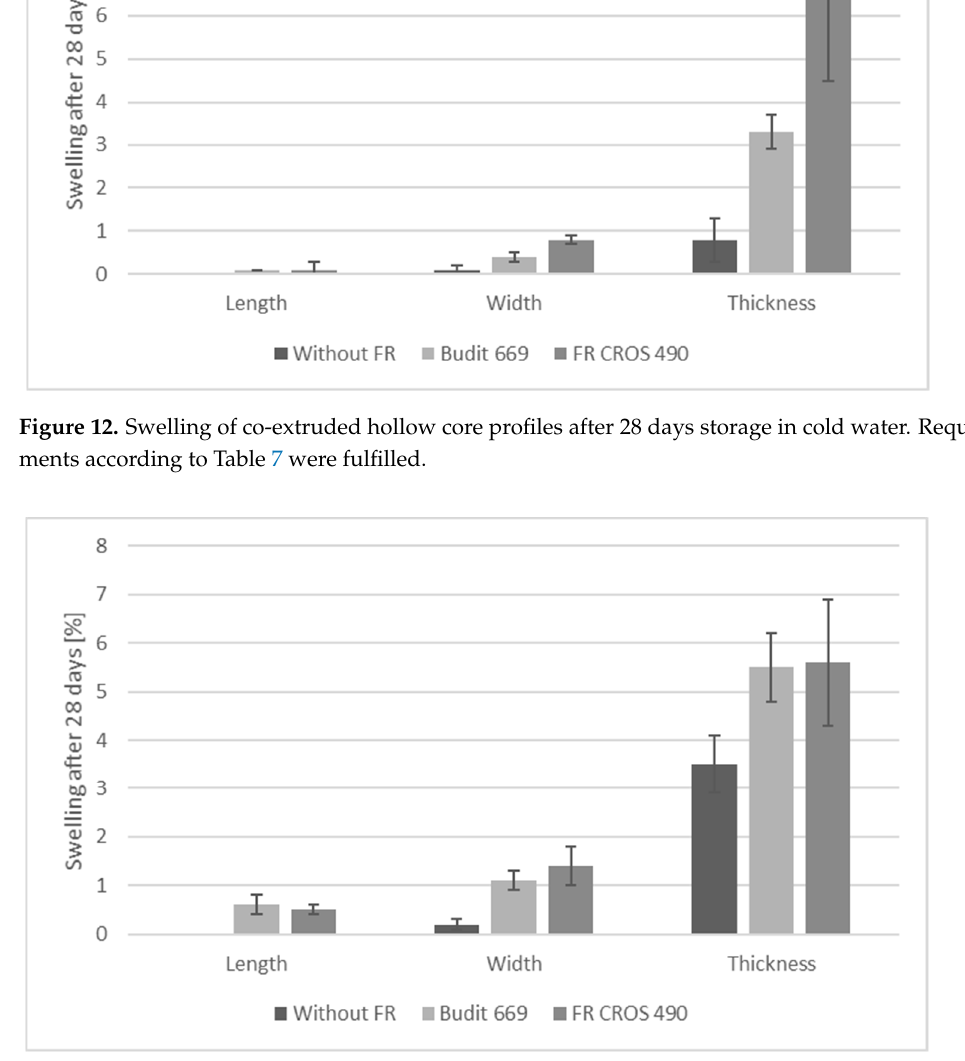
Figure 13. Swelling of co-extruded solid profiles after 28 days storage in cold water. Requirements according to Table 7 were fulfilled.